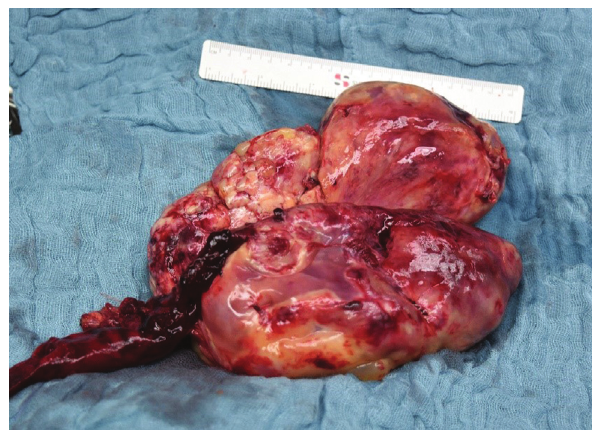
Fig. 2 Resected thecoma (17cm (cid:1) 14.5cm (cid:1) 7.5cm; 710g) with adherent greater omentum.